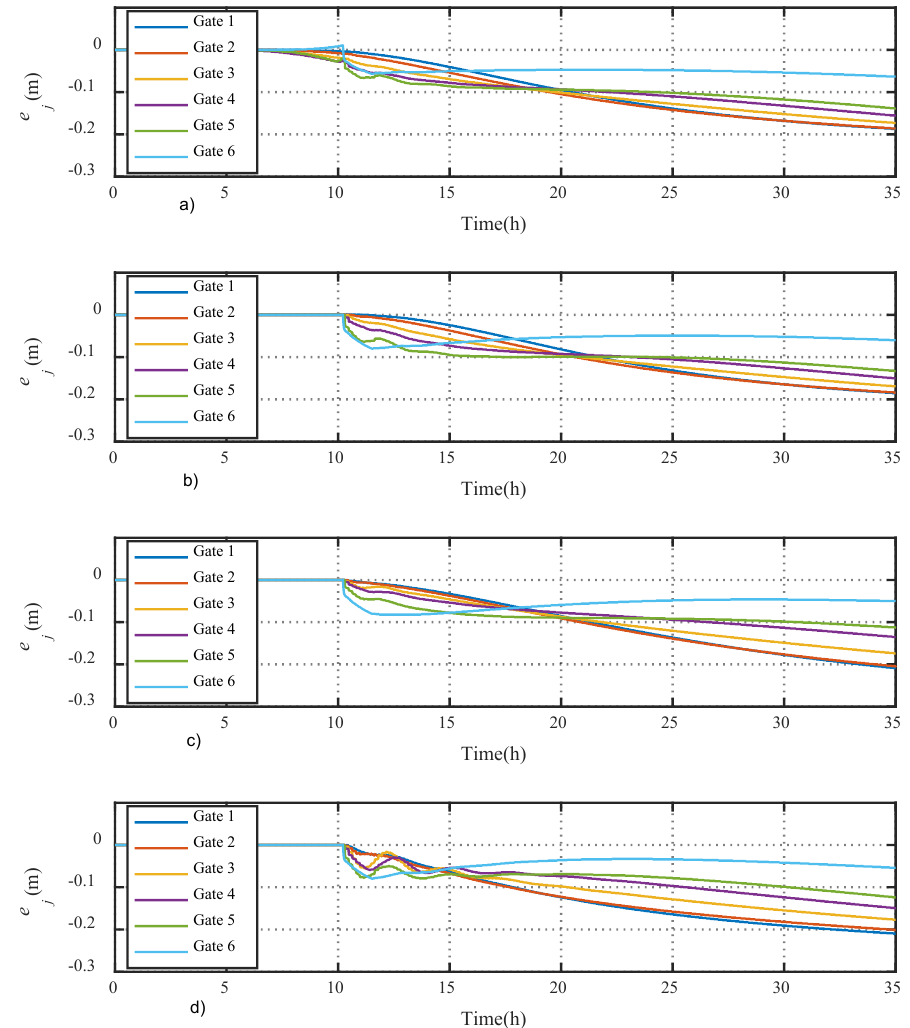
Figure 4. The simulation water level deviation result for scenario No. 2 with MPC-I control ( a ), MPC-I control ( b ), LQR I ( c ), and LQR II ( d ).